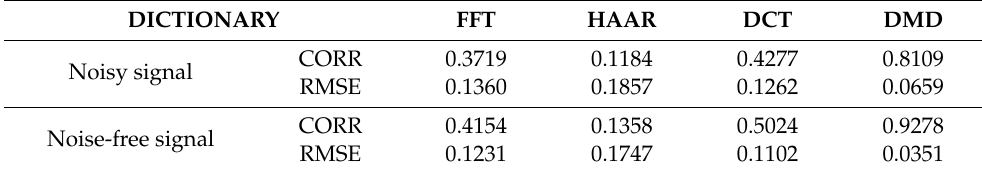
Table 2. Average value of time and quality, reconstructed by different methods.